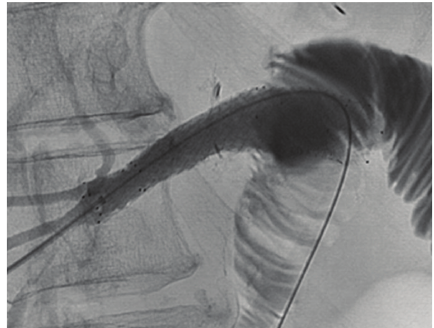
Figure 6: Biliary stenting of posterior sectoral anastomosis. Twelve weeks after operation to restore biliary-enteric drainage, interven- tional radiology placed overlapping SMART stents (Cordis, Miami Lakes, FL) across the posterior sectoral biliary-enteric anastomosis to prevent fibrosis of the tract not lined by bile duct